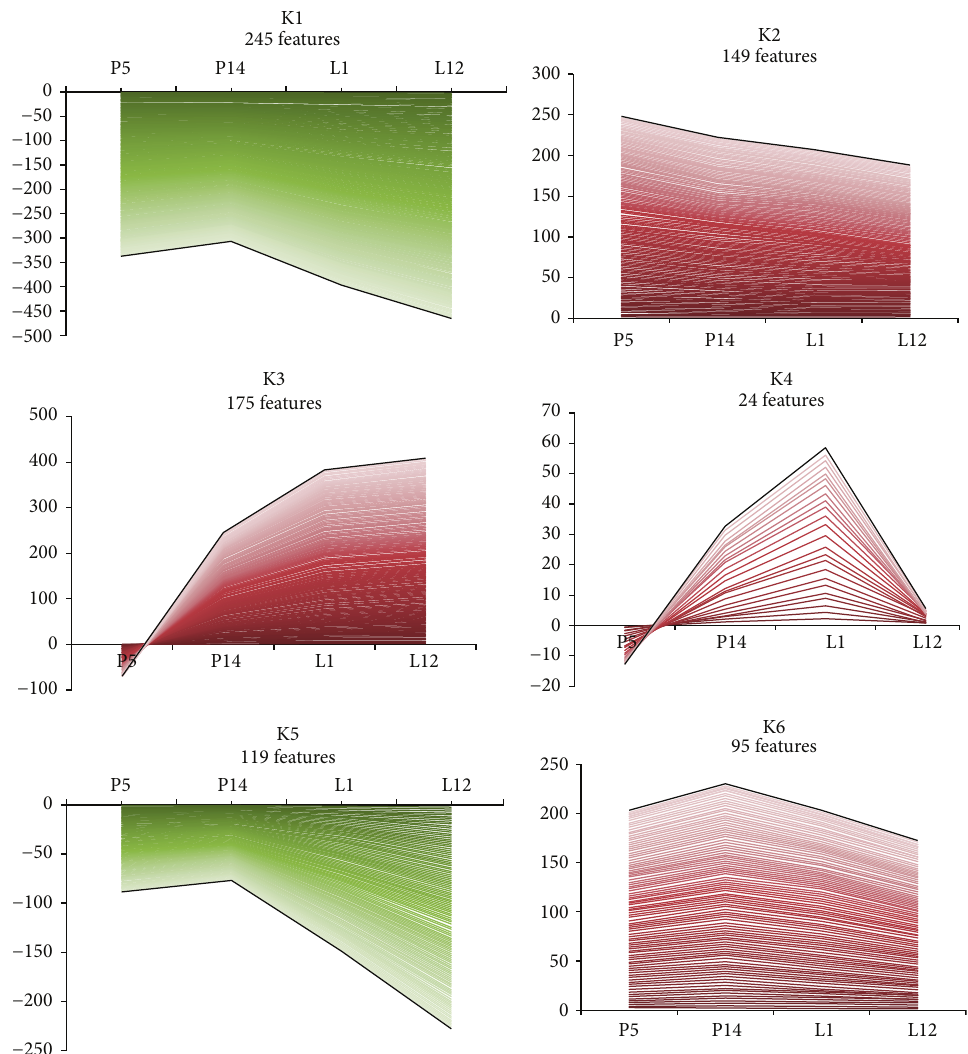
Figure 4: K-means clustering of the differentially expressed gene list with trajectory expression profile signatures. Gene expression data from the 807 tags comprising the significant altered gene transcript list ( z -score > ± 1.50) were best represented by six K-means clusters consisting of distinct up (red) and down (green) patterns of expression. Developmental stage time points and fold change are indicated on the x - and y -axes, respectively. The numbers of tags in each cluster are indicated. A black pseudoline representing the general (average) pattern of expression has been superimposed on each